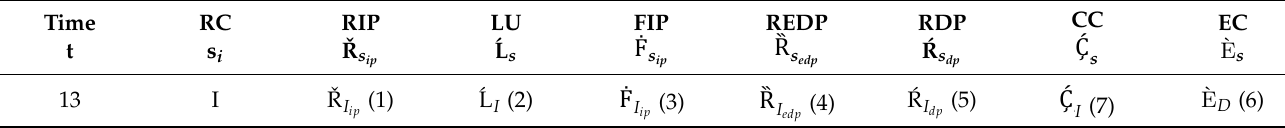
Table 8. IMU process at t = 13.